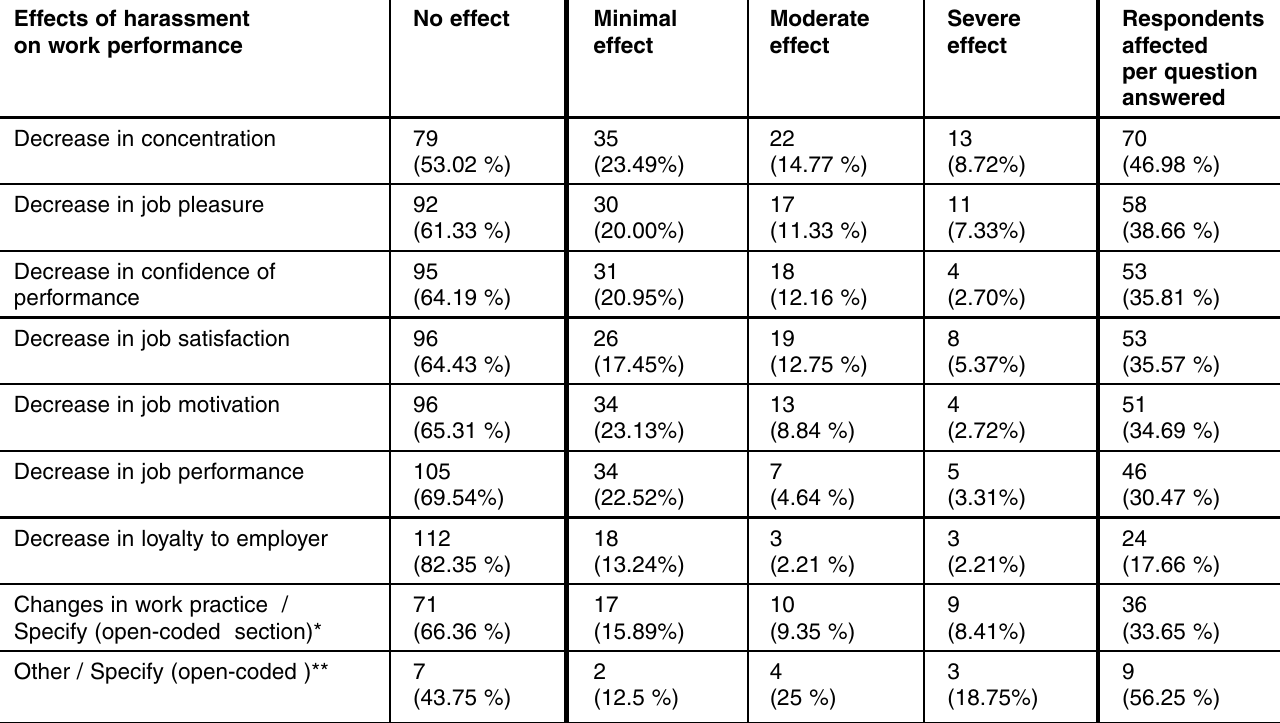
Table 4: Effects that sexual harassment had on work performance of